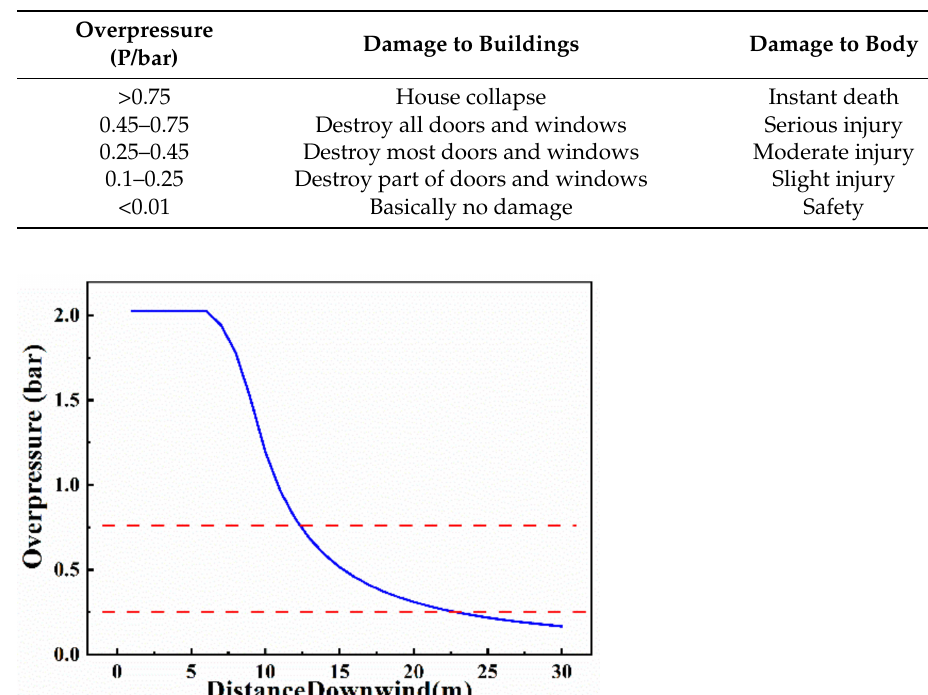
Table 8. The harm of overpressure to people and buildings.